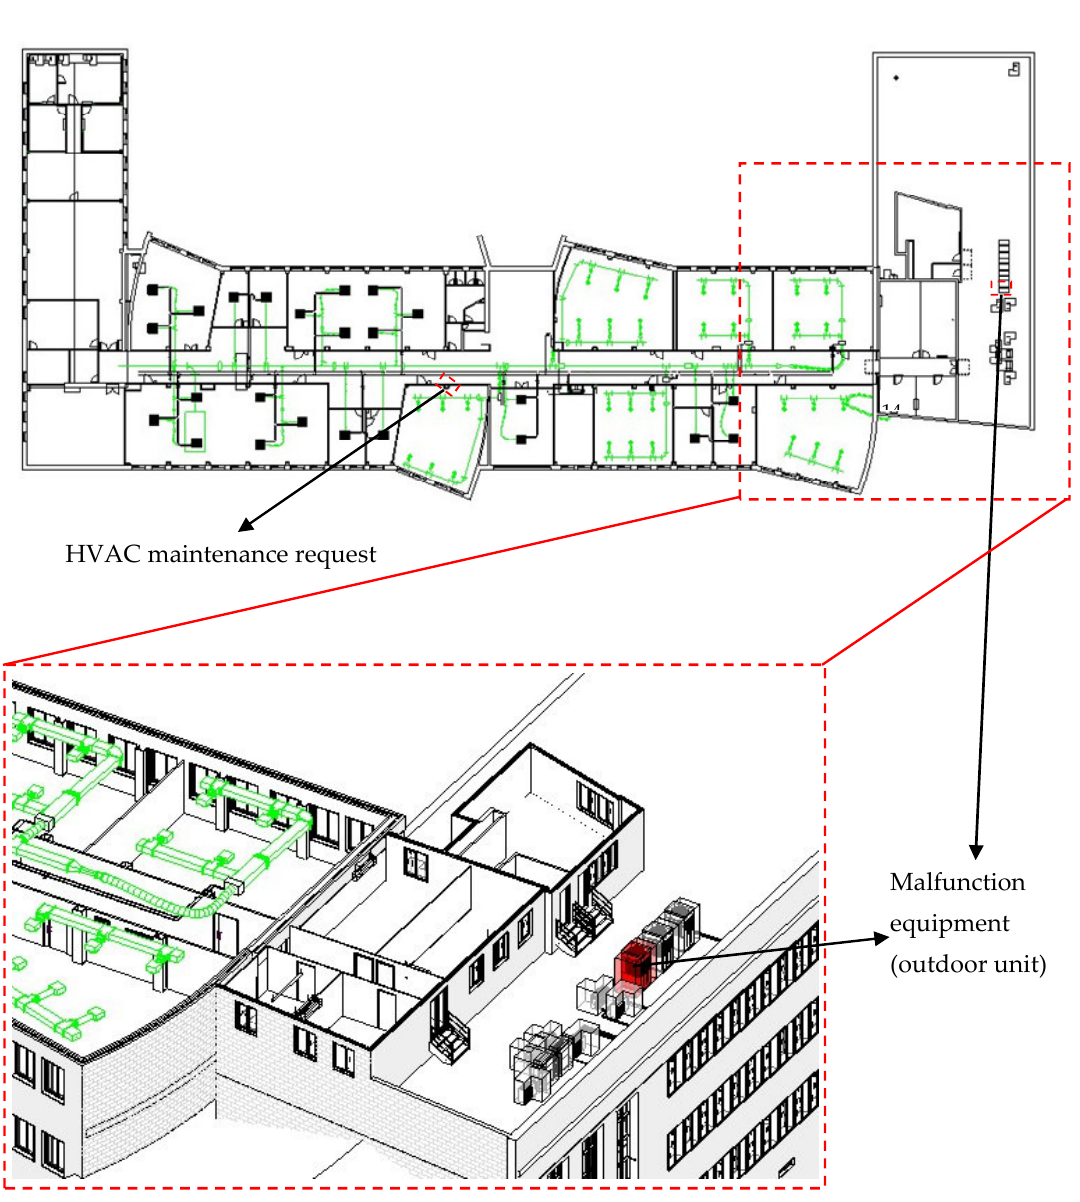
Figure 5. Visualization of the possible causes of the problem in BIM.